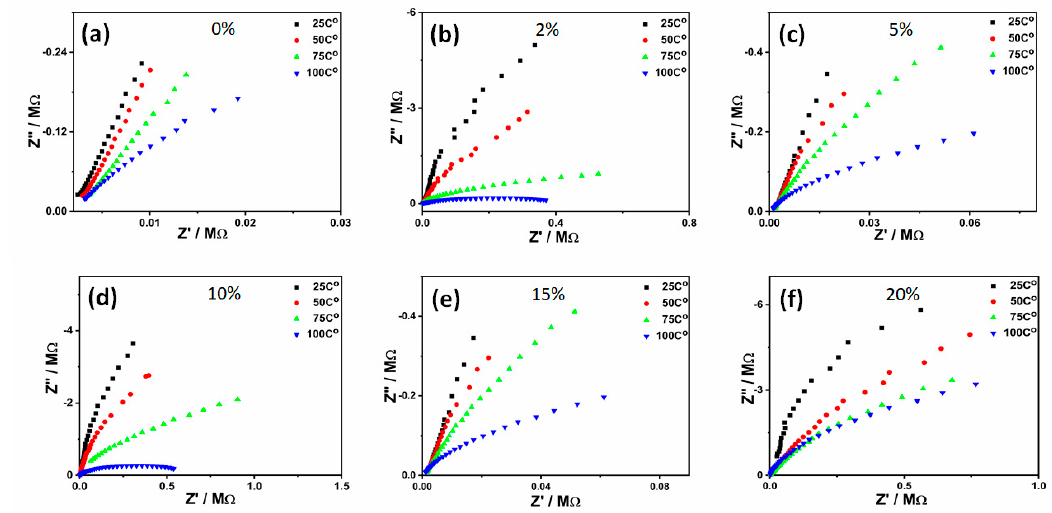
Figure 5. Electrical impedance measurements of the PVA-glycerol-Fe 3 O 4 membranes at nanoparticles’ concentrations of ( a ) 0%, (b) 2%, ( c ) 5%, ( d ) 10%, ( e ) 15%, and ( f ) 20%.